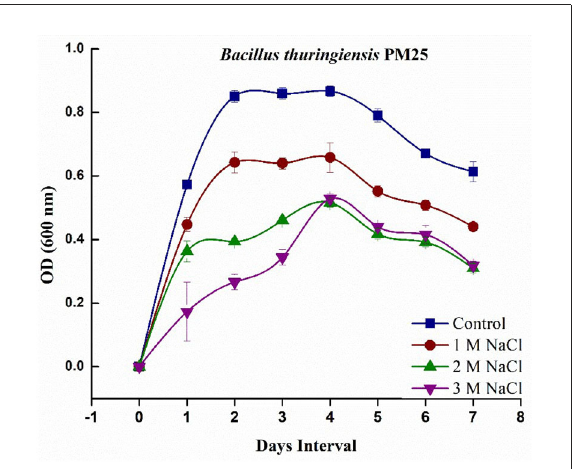
FIGURE1 Growth curve analysis of Bacillus thuringiensis PM25 under salinity stress (0, 1, 2, and 3M NaCl).